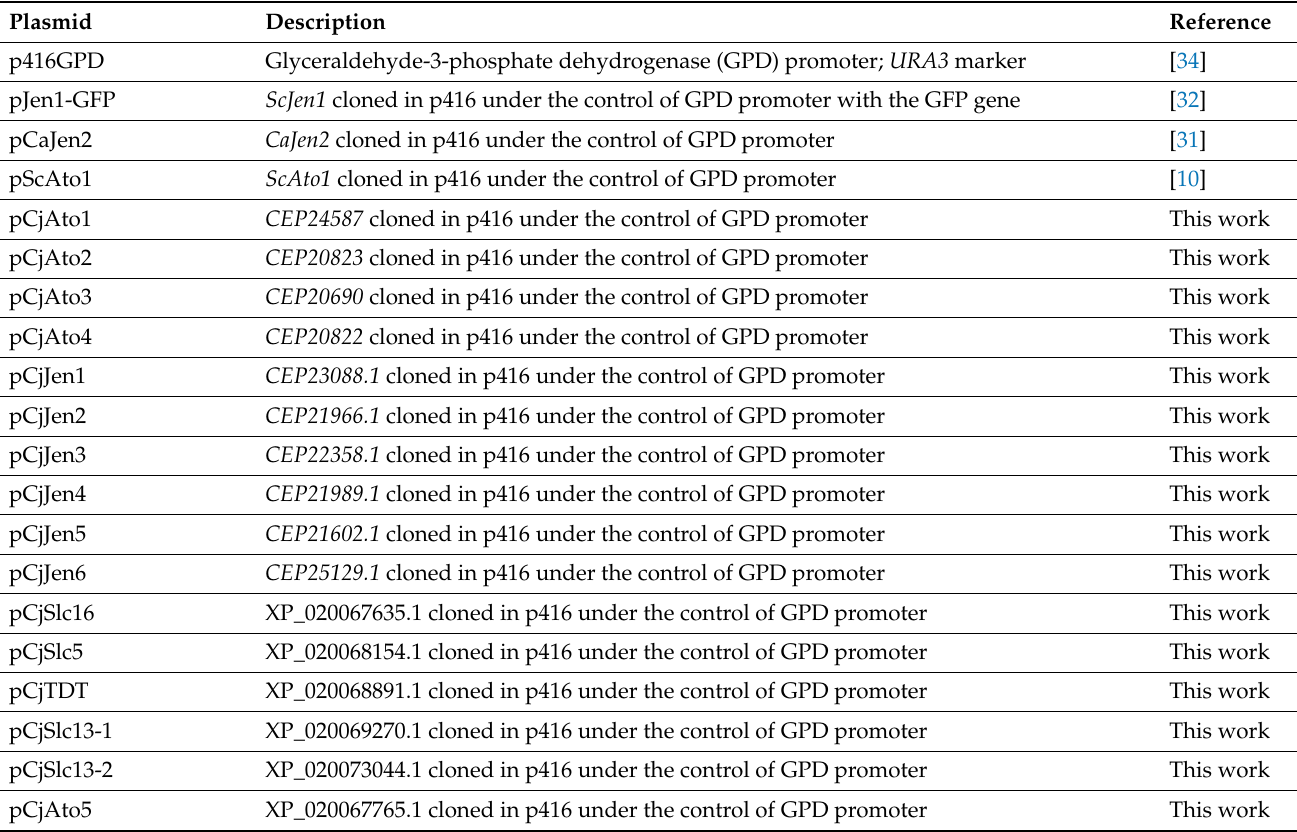
Table 2. Plasmids used in this